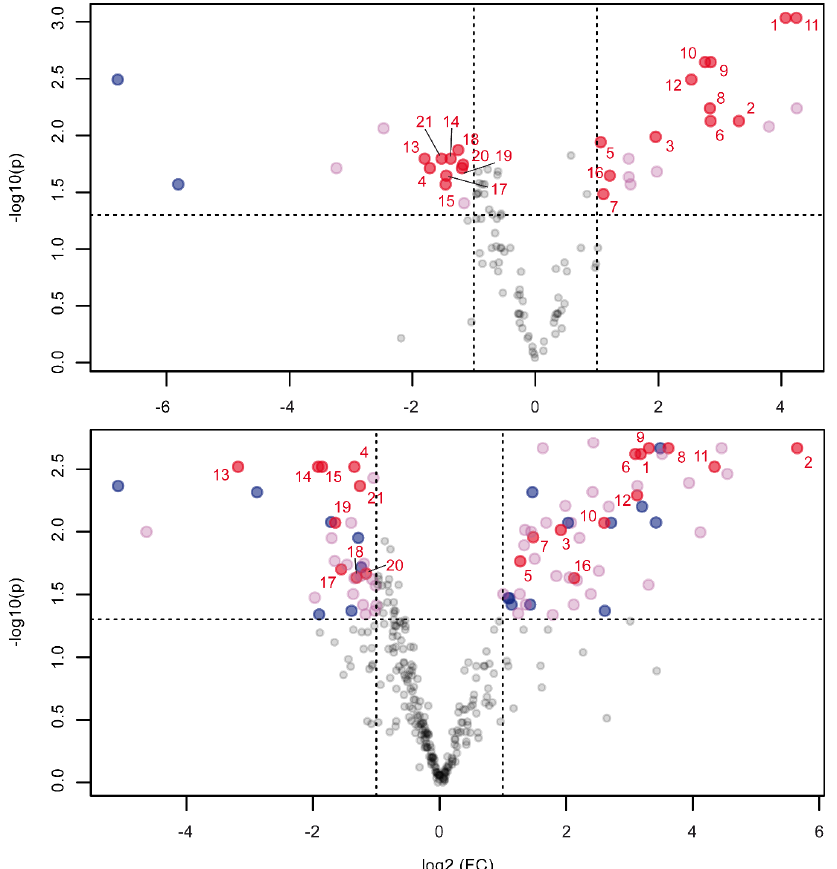
Figure 3. Volcano plot analysis of the comparative metabolomics experiment on salinity stress of microalgae. Samples were split and measured on both the unit-mass ISQ GC–MS (top) and the high-resolution Orbitrap GC–MS (bottom). Compounds exceeding a fold change (FC) of 2 (peak area from control to stressed) and below a p -value of 0.05 are deemed significantly dysregulated and are plotted in red. Marked in blue are processing artifacts that were not discernible from the background noise upon manual inspection. This left 30 compounds in the ISQ GC–MS and 68 compounds in the Orbitrap GC–MS dataset, respectively. Highlighted in red and numbered are the same compounds found to be significant in both datasets.